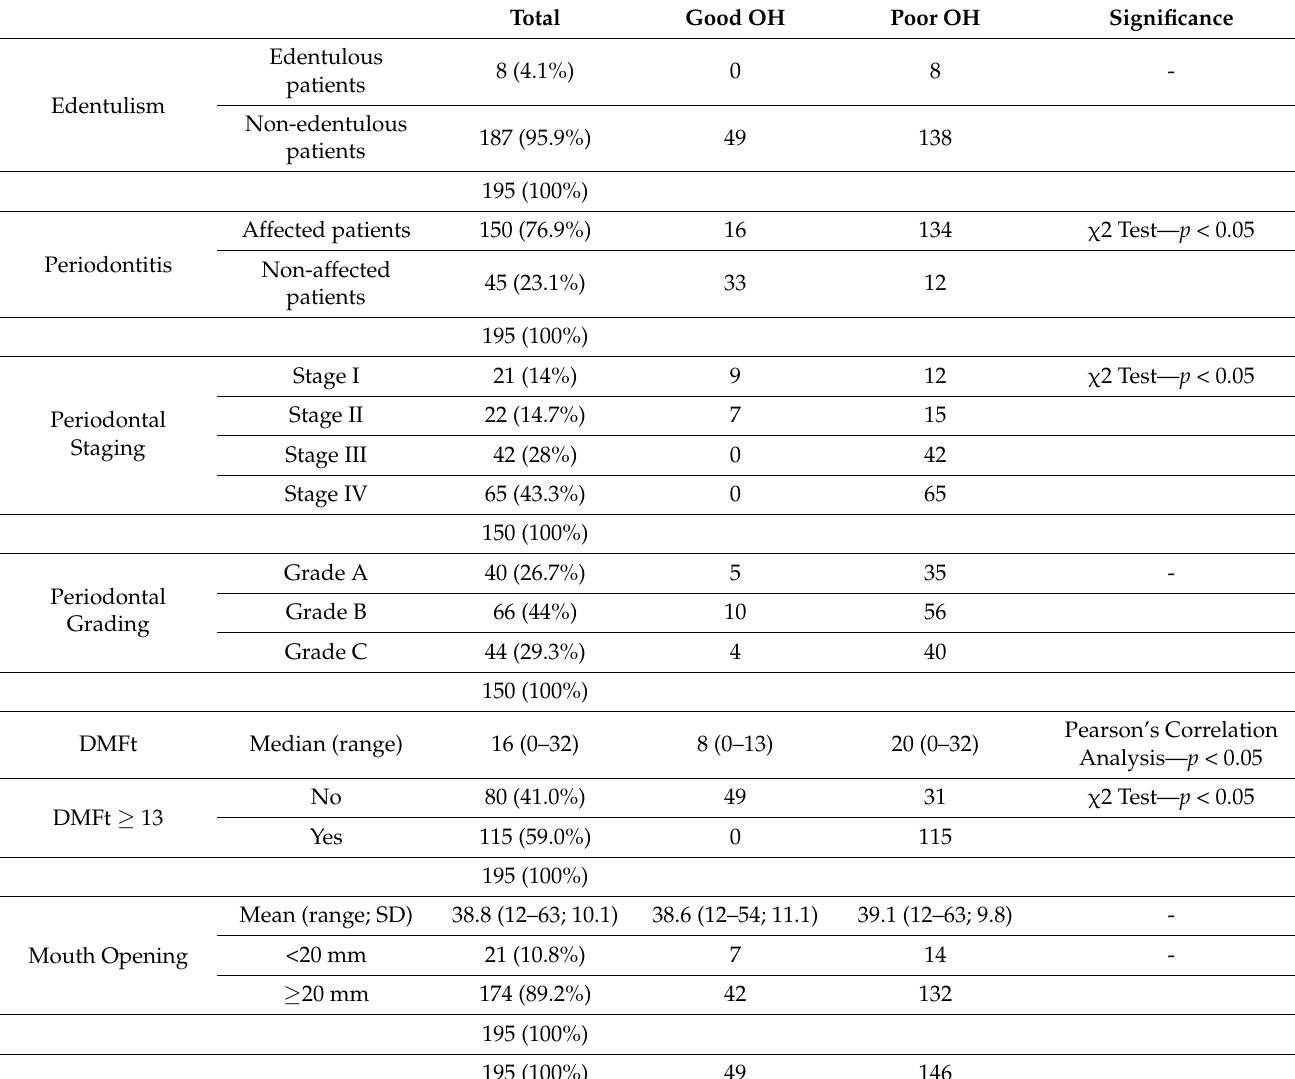
Table 2. Oral health parameters of the studied population and correlation with OH. SD: stan- dard deviation. Good OH Poor OH